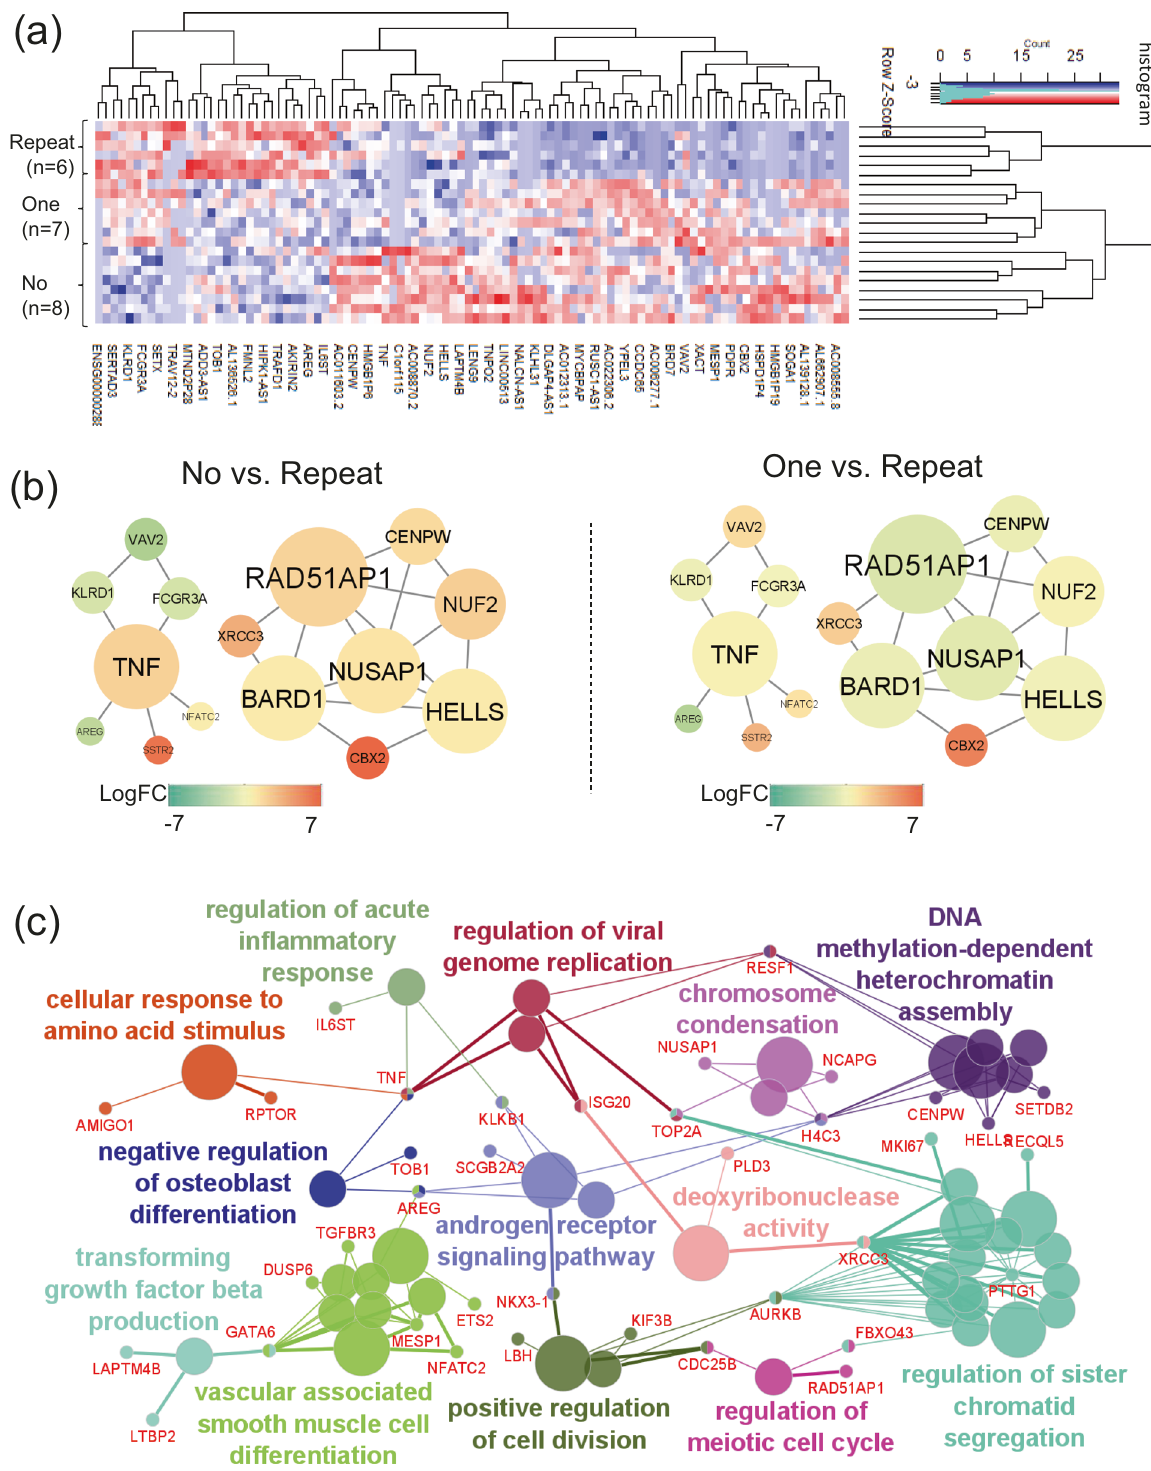
Fig. 5 Gene expression pro fi le (GEP), protein – protein interaction (PPI) network, and gene ontology (GO) enrichment analyses in HLA-A24-restricted CMV-pp65-speci fi c cytotoxic T-cells (CMV-CTL) according to the CMV reactivation pattern in the early phase of allo-HCT. a A clustering heatmap of GEP using the top 100 differentially expressed genes (DEGs) according to the CMV-reactivation pattern: no-CMV reactivation (no-group, n = 8), one- episode of CMV reactivation (one-group, n = 7), and repeated episodes of CMV reactivation (repeated-group, n = 6). b PPI network constructed by the top 100 DEGs which had close connections with each other. The shape size suggests the degree of centrality of the PPI network, meaning how many edges are connected to each gene node. The heat color denotes the log-fold changes in individual gene expression between the no- vs. repeated- groups or between the one- vs. repeated groups. Only the networks with ≥ 5 connections are shown. c GO and the shared genes derived from the top 200 DEGs. Each circle denotes an identi fi ed term with a P -value of <0.05 without the Bonferroni correction. The same colors mean GO terms that belong to the same GO term- tree groups. Only the names of the leading GO terms with highest signi fi cance in each GO term-tree group are